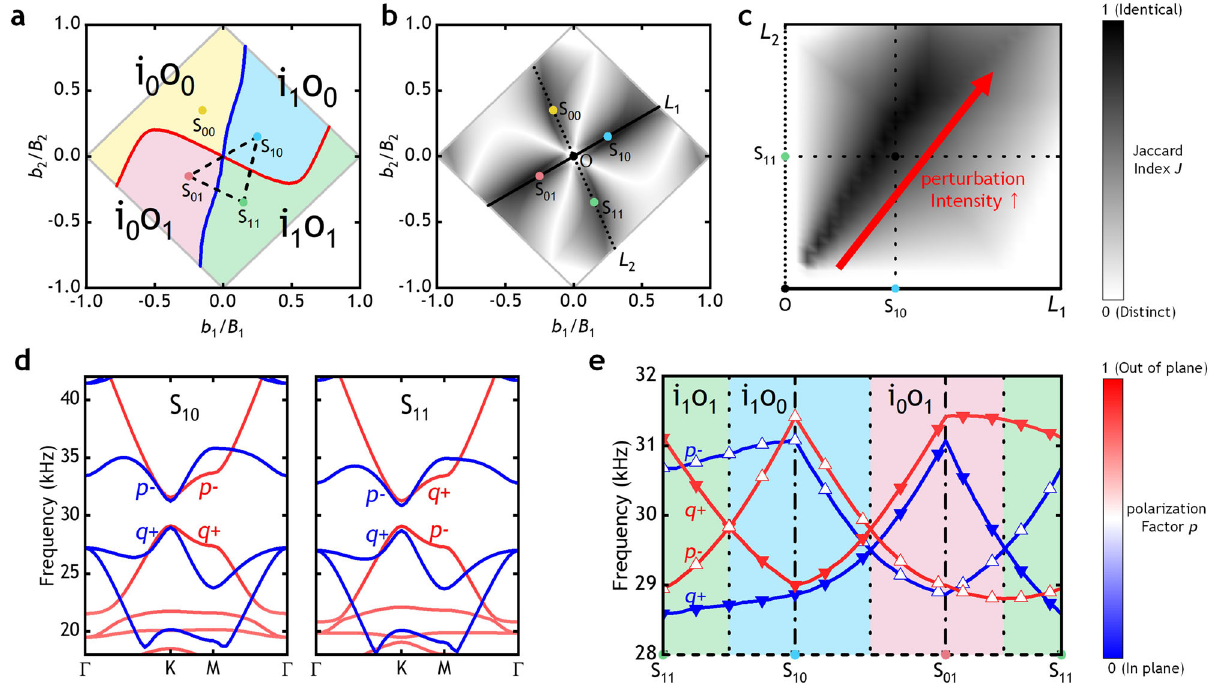
Fig. 4 Phononic crystals (PCs) for the topological protection selected based on the Jaccard index. a Feasible PCs S 00 , S 10 , S 01 , and S 11 in the superposed phase diagram with c = 0.25. S 00 , S 10 , S 01 , and S 11 are named after their superposed topological phase. Black dashed triangles have vertices S 10 , S 01 , and S 11 , and used in ( e ). b Jaccard index between in-plane polarized (IPP) bandgap and out-of-plane polarized (OPP) bandgap of the PCs with c = 0.25. Line L 1 and L 2 indicates perturbation sets possessing large Jaccard index approximately, where index between intersected bandgaps (intersection of IPP and OPP bandgap) of L 1 and L 2 . Part of the graph which can be drawn by symmetry is omitted. The red arrow indicates the perturbation intensity hierarchy of the PC pairs having large Jaccard indices. d Energy band structures of the PCs S 10 and S 11 . The overall common bandgap is from 29.0 to 30.7 kHz, so the width of the bandgap is 5.7%. e Superposed phase diagram of PCs on the black dashed triangle shown in ( a ). Only IPP (OPP) phase transits between S 01 and S 11 (S 11 and S 10 ) owing to the accidental Dirac degeneracy while both IPP and OPP phase transits between S 10 and S 01 , mirror-symmetry